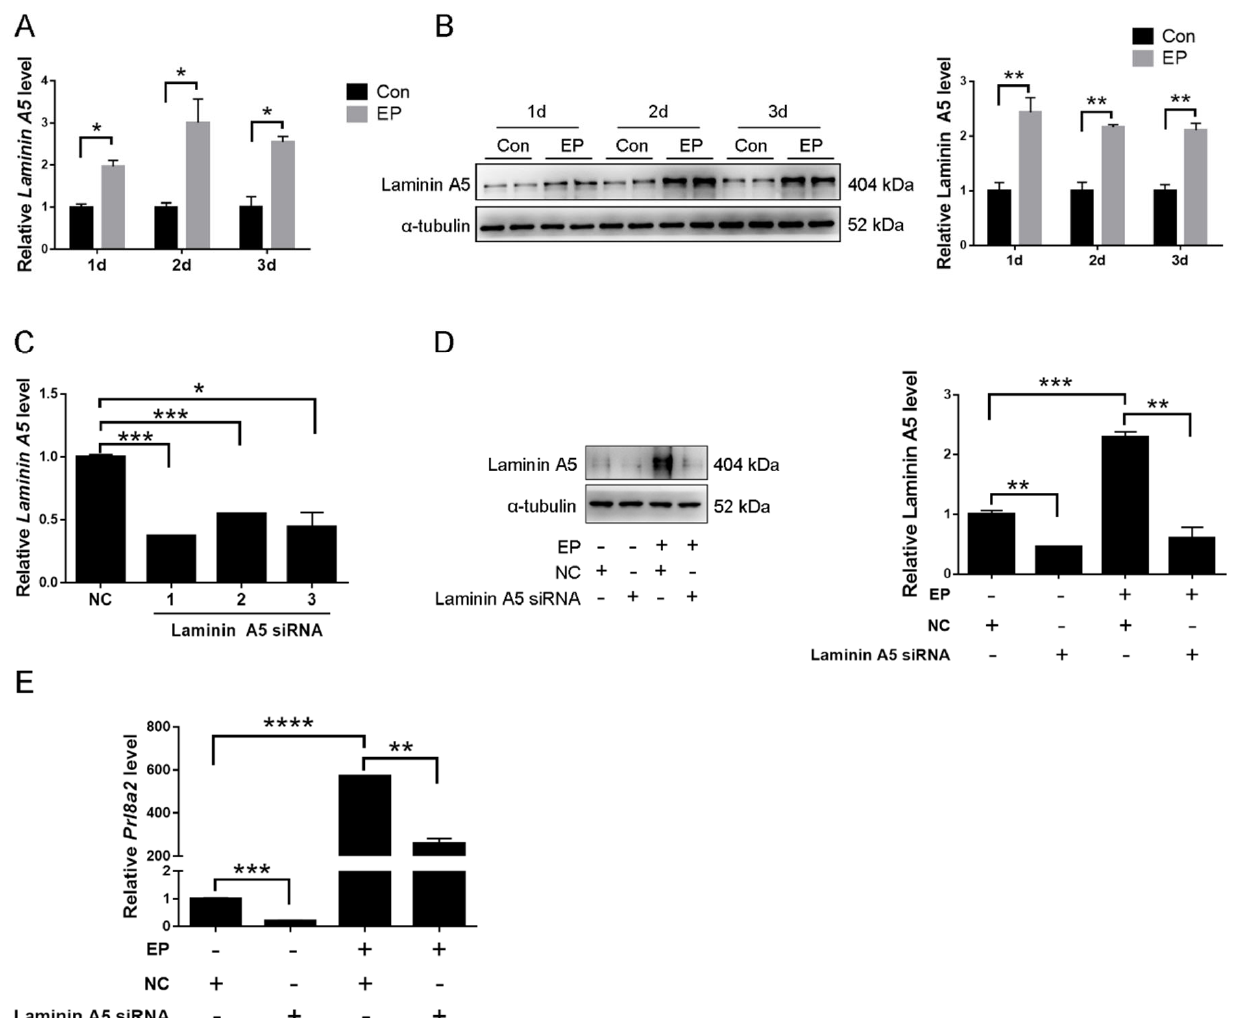
Figure 3. Regulation and function of laminin A5 during mouse in vitro decidualization. ( A ) RT-qPCR analysis of Laminin A5 mRNA level. ( B ) Western blot analysis of laminin A5 protein level. ( C ) RT-qPCR analysis on the effect of Laminin A5 siRNAs on Laminin A5 mRNA level in stromal cells. ( D ) Western blot analysis of laminin A5 protein level after decidualized stromal cells were treated with Laminin A5 siRNA. ( E ) Effects of Laminin A5 siRNA on Prl8a2 expression. Bars represent mean ± SD (* p -value < 0.05, ** p -value < 0.01, *** p -value < 0.001, **** p -value < 0.0001). EP, 17 β -estradiol + progesterone; NC, negative control.